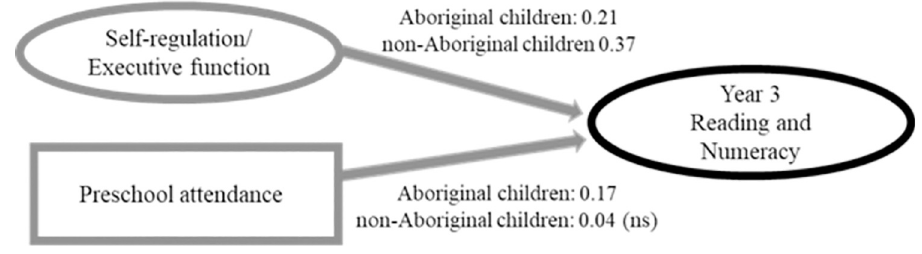
Fig 2. The direct path model. All path coefficients are